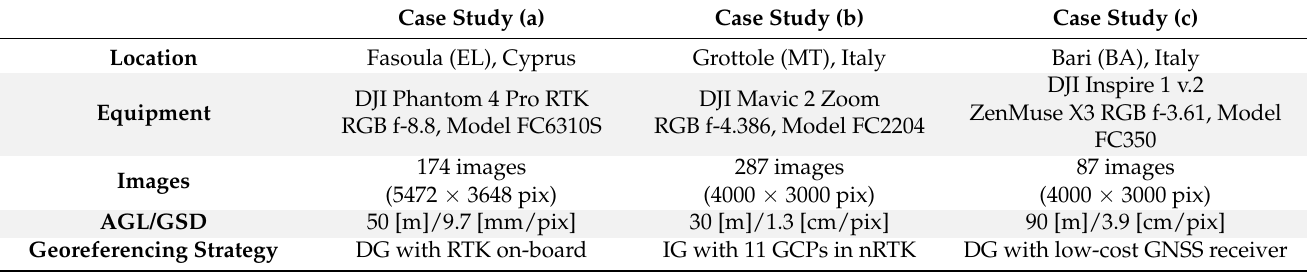
Table 1. Overview of surveyed scenarios adopted technologies and acquired datasets.